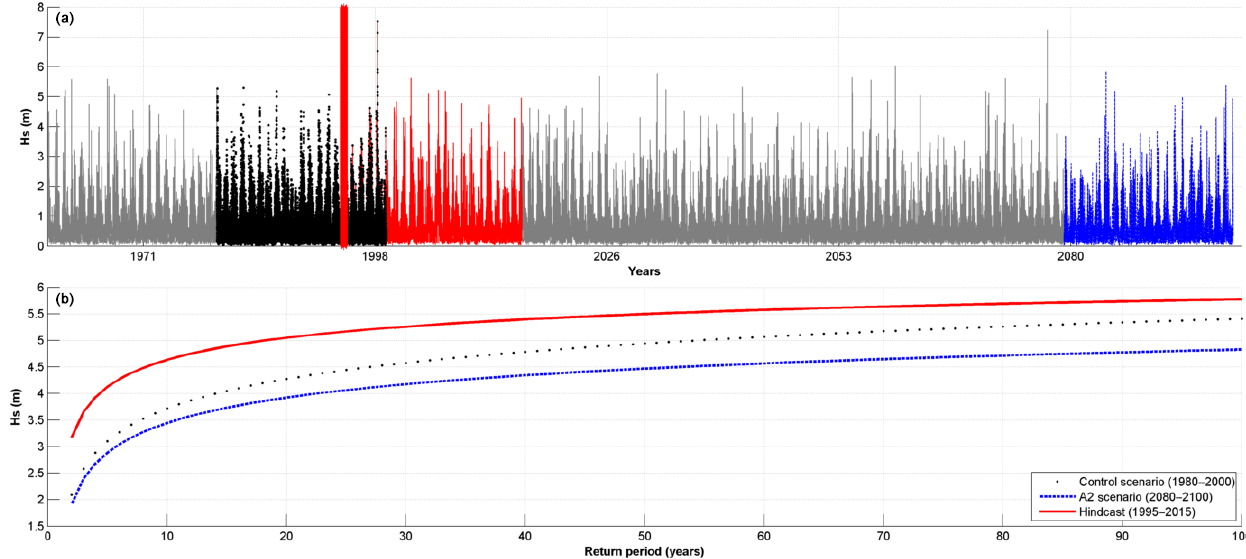
Figure 5. Return periods in the A2 scenario for future projections (blue dashed line), control simulation (black dotted line) and hindcast (red line). Note that there are different time periods for the series as well as the overlapping of hindcast and control scenarios. The red line indicates the 1st day of hindcast time series.